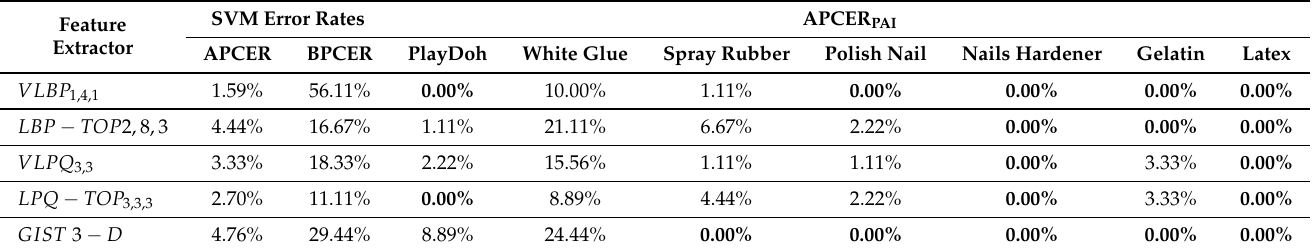
Table 9. Attacks strength considering different PAI species (thermal sensors). Feature